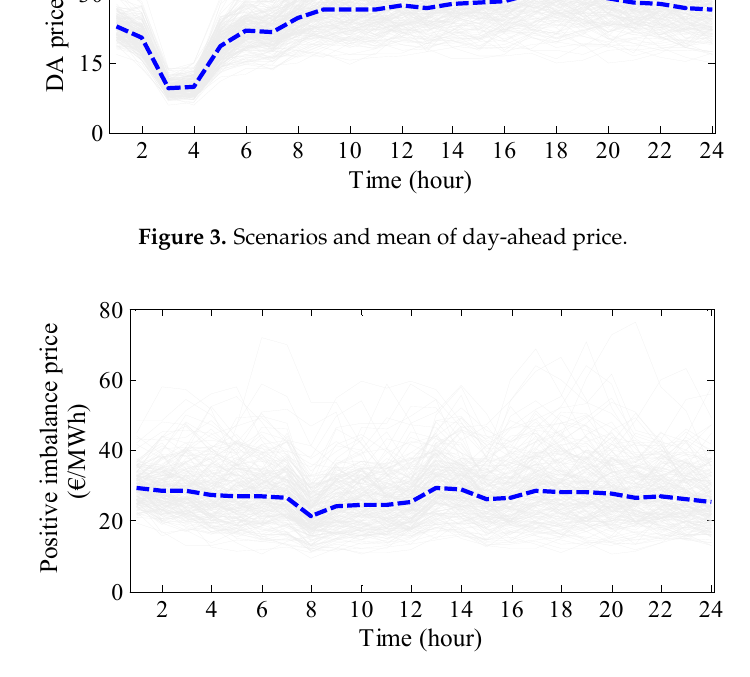
Figure 4. Scenarios and mean of positive imbalance price.